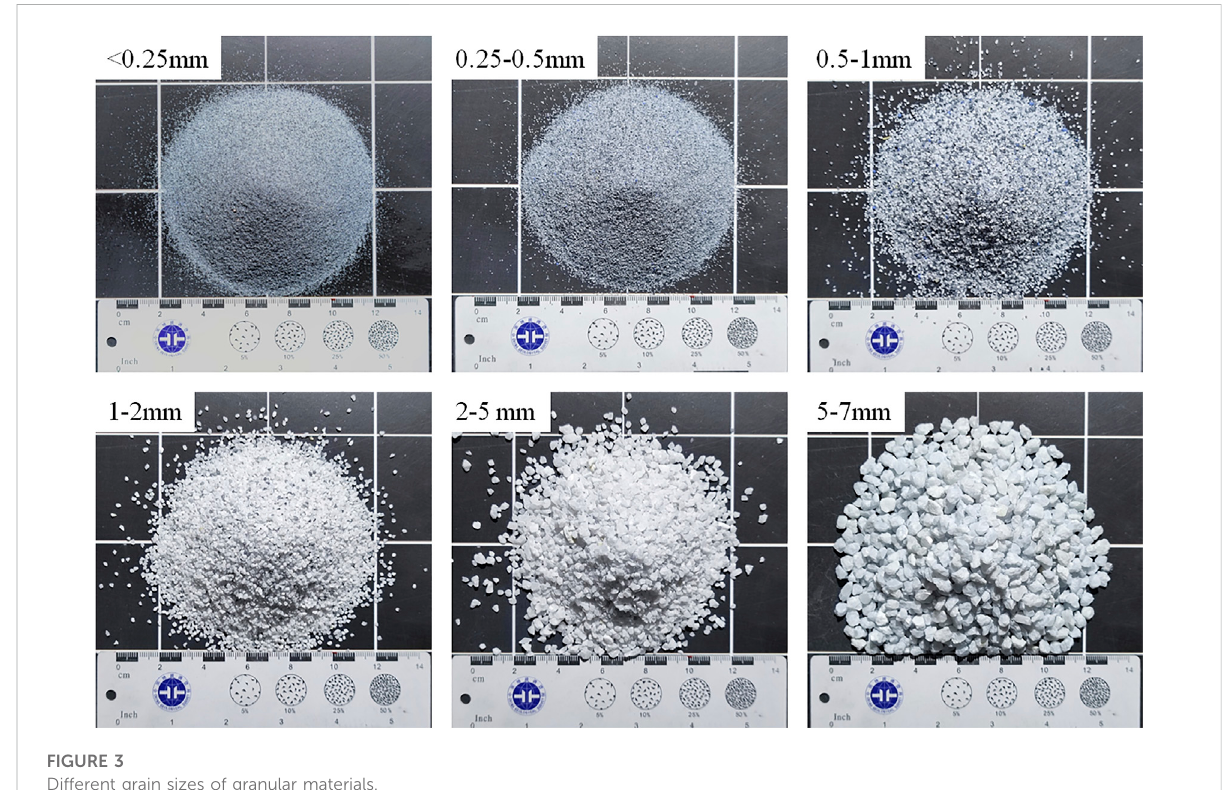
FIGURE 3 Different grain sizes of granular materials.